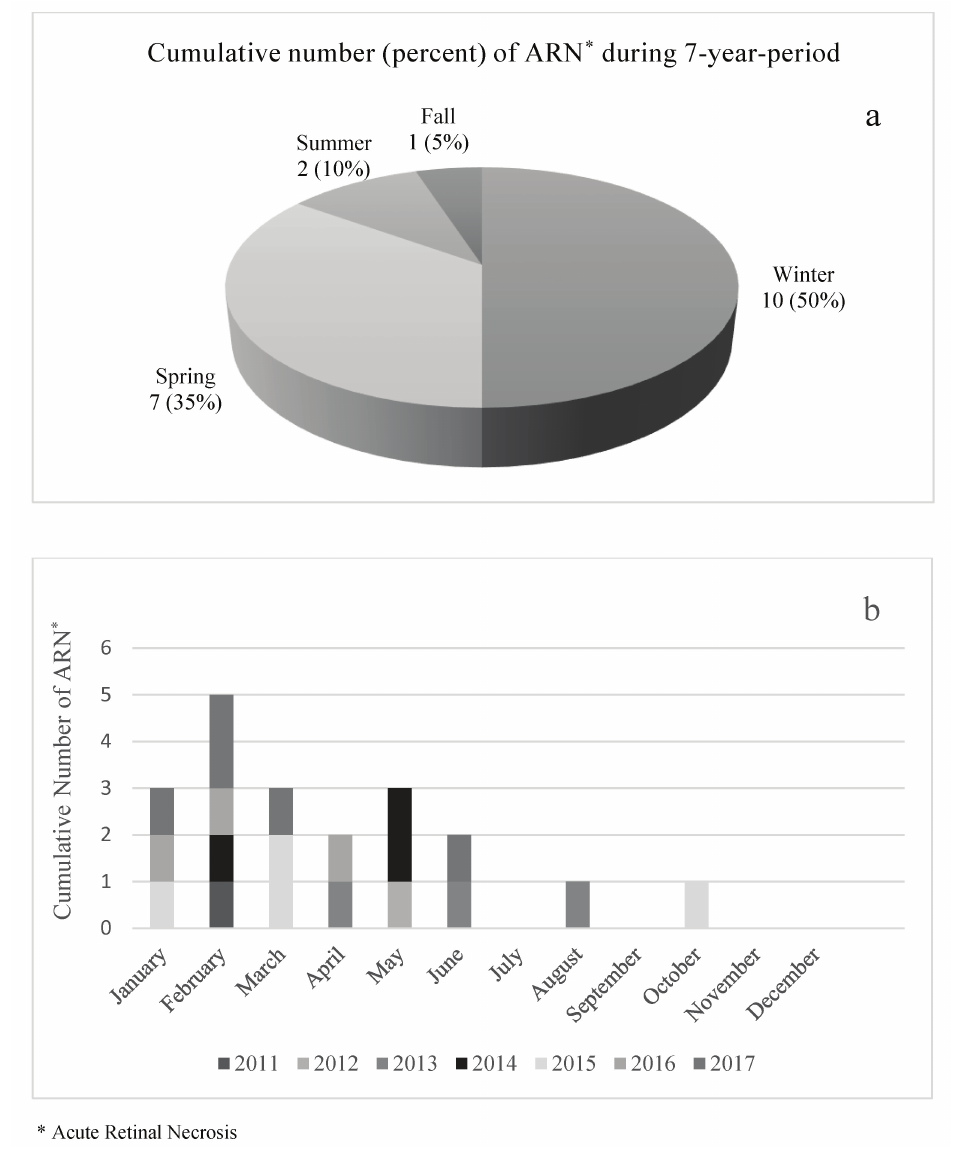
Figure 1. Cumulative number of cases of acute retinal necrosis in each season (a) and month